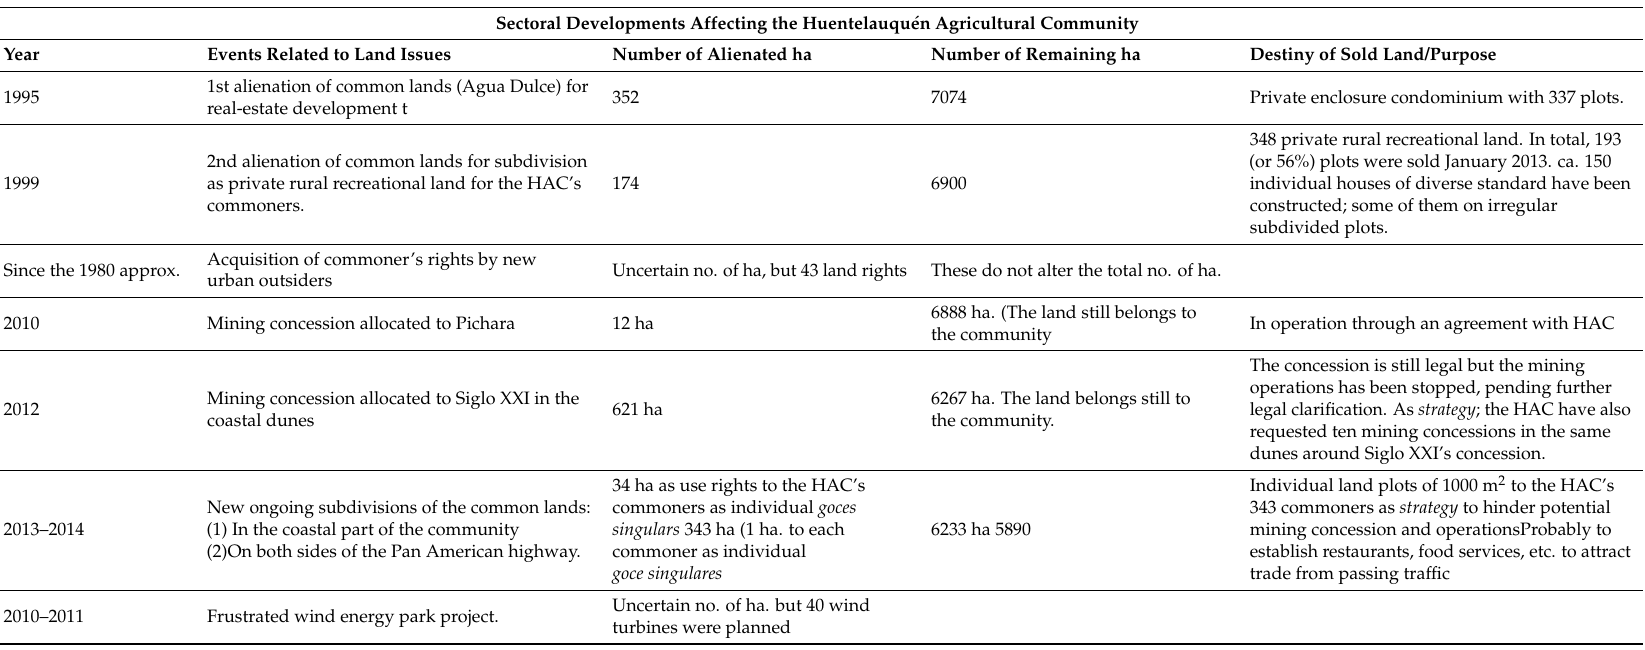
Table 3. Historic time-line of the different sectoral developments affecting the Huentelauqu é n Agricultural